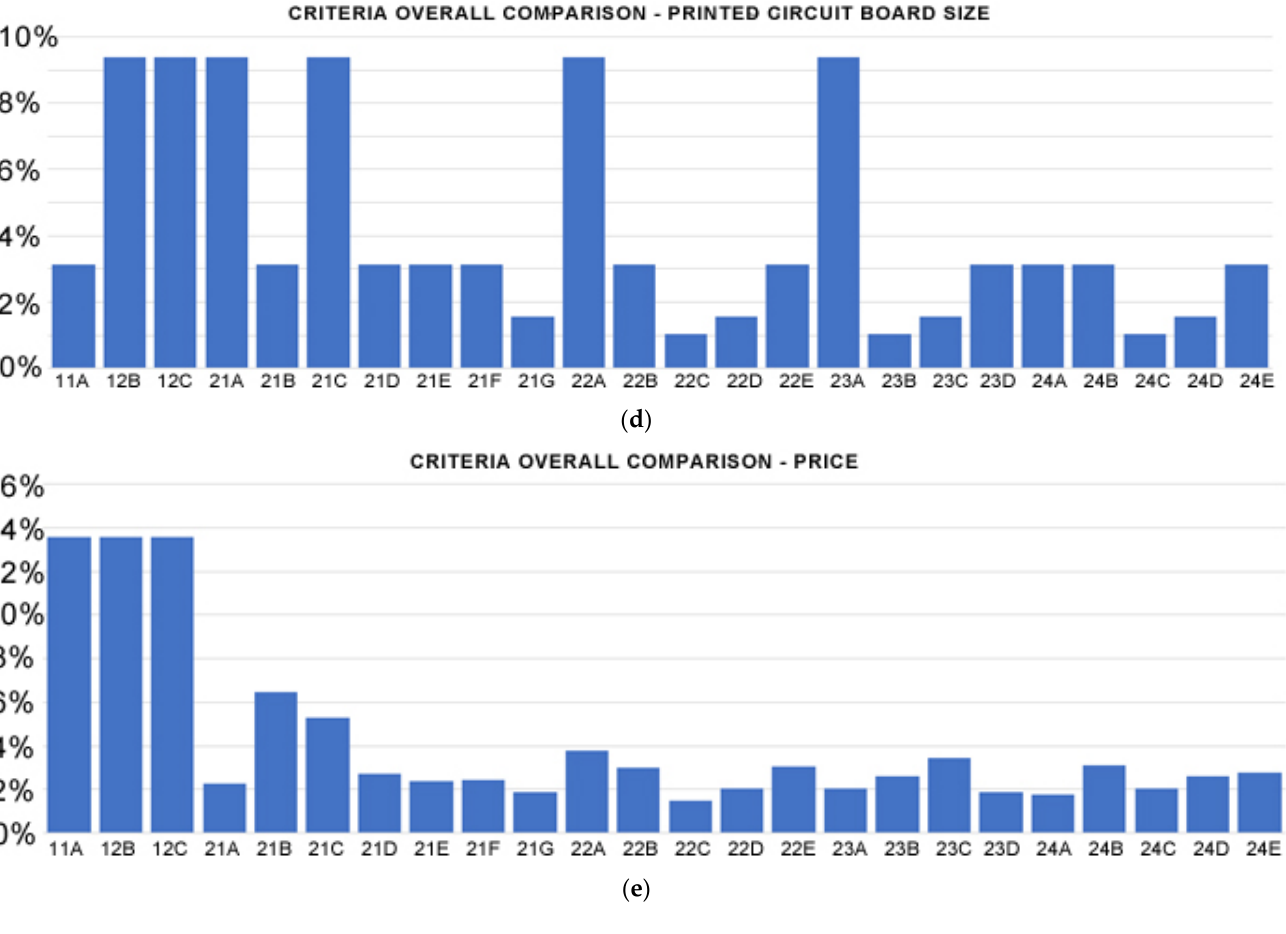
Figure 4. ( a ) Energy Efficiency normalized result comparison of all twenty-four SoC equalization methods; ( b ) Equalization Speed normalized result comparison of all twenty-four SoC equalization methods; ( c ) Implementation Simplicity normalized result comparison of all twenty-four SoC equal- ization methods; ( d ) PCB Size normalized result comparison of all twenty-four SoC equalization methods; ( e ) Price normalized result comparison of all twenty-four SoC equalization methods.